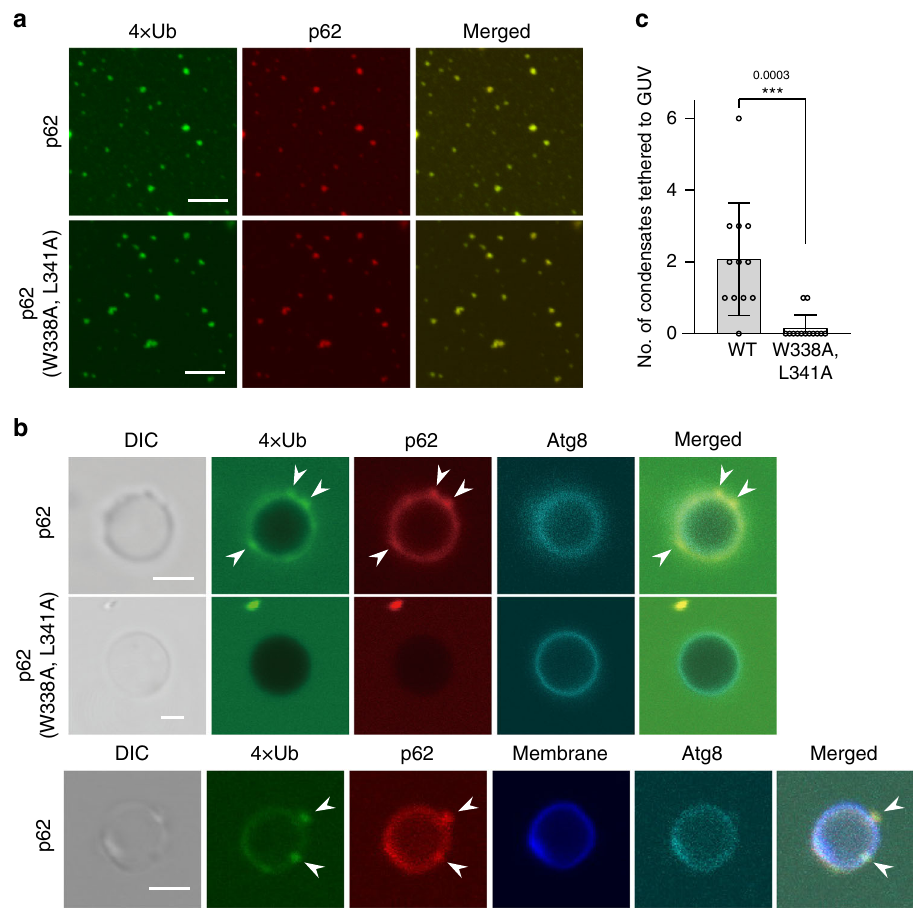
Fig. 3 p62-4xUb condensates interact with Atg8-GUVs depending on the LIR-Atg8 interaction. a In vitro formation of p62-4xUb condensates. 5 μ M mCherry-p62, 50 μ M 4xUb and 5 μ M SNAP-4xUb labeled with AlexaFluor 488 were mixed and observed by fl uorescence microscopy. Bars: 5 μ m. b Interaction analysis of p62-4xUb condensates with Atg8-GUVs. p62-4xUb condensates as prepared in a were incubated with mKalama1-Atg8-GUVs and observed by fl uorescence microscopy. DIC differential interference contrast. Arrowheads indicate p62-4xUb condensates on the Atg8-GUV. Bars: 2 μ m. c Quanti fi cation of the experiments in b . GUVs were randomly selected ( n = 12 and 13 for WT and W338A L341A, respectively) and the number of attached condensates was counted. Data are means± s.d of wild-type and W338A L341A condensates attached with a GUV. *** P < 0.001 as determined by two-sided Student ’ s t -test. Source data are provided as a Source Data fi